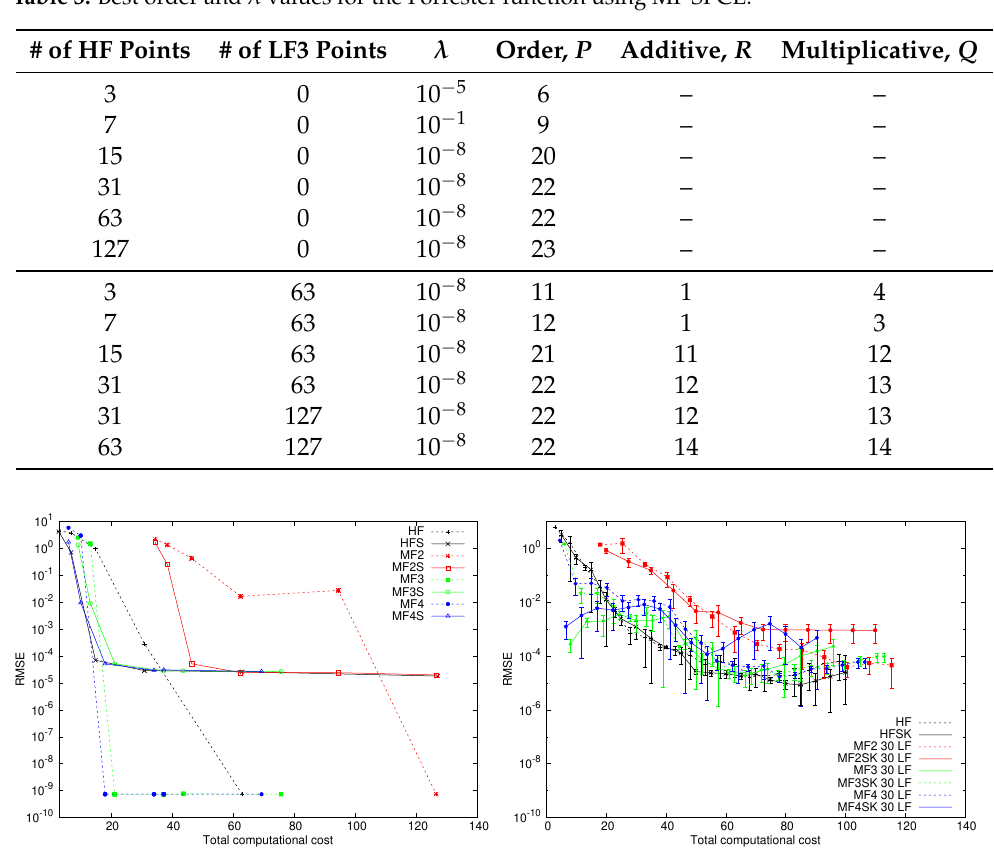
Table 3. Best order and λ values for the Forrester function using MF SPCE.